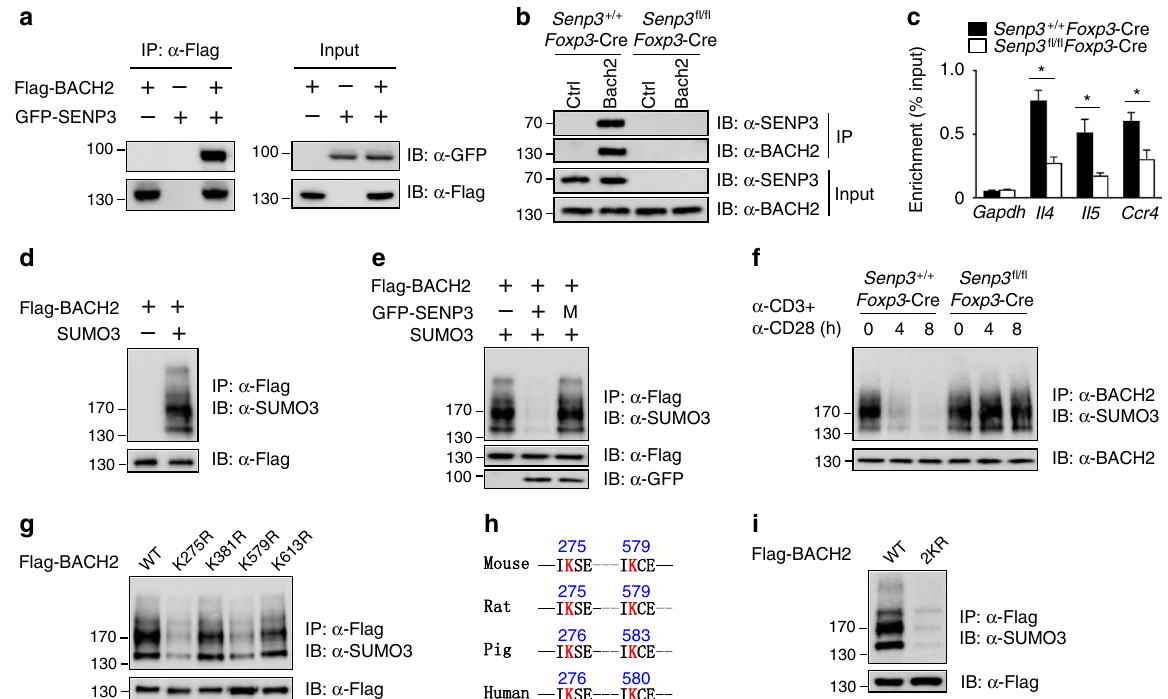
Fig. 5 SENP3 mediates BACH2 deSUMOylation in Treg cells. a SENP3-BACH2 co-immunoprecipitation (co-IP) assays using HEK293 cells transfected with the indicated expression vectors. b Lysates from Senp3 + / + Foxp3 -Cre and Senp3 fl / fl Foxp3 -Cre splenic Treg cells stimulated with anti-CD3 and anti-CD28 antibodies for 24 h were subjected to IP using anti-BACH2 antibody or control Ig (Ctrl); BACH2 and BACH2-associated SENP3 were detected by immunoblotting (IB). c ChIP assay to evaluate the binding of BACH2 to the regulatory regions of Il4 , Il5 , and Ccr4 loci in Senp3 fl / fl Foxp3 -Cre and Senp3 + / + Foxp3 -Cre splenic Treg cells stimulated with anti-CD3 and anti-CD28 antibodies for 24 h. d , e BACH2 SUMOylation assays using HEK293 cells transfected with the indicated expression vectors. f BACH2 SUMOylation assays using Senp3 + / + Foxp3 -Cre and Senp3 fl / fl Foxp3 -Cre Treg cells stimulated with anti-CD3 and anti-CD28 antibodies for 0, 4 or 8 h. g Flag-tagged mouse BACH2 or its mutant variants were individually transfected into HEK293T cells for BACH2 SUMOylation assays. h Sequence alignment of the K275 and K579 SUMOylation sites of BACH2 in different species and conserved residues (red) are shown. i Flag-tagged mouse BACH2 (WT) or K275R and K579R mutant BACH2 (2KR) were individually transfected into HEK293T cells for BACH2 SUMOylation assays. All data shown are representative of three independent experiments. Error bars are the mean ± SEM values ( c ). Two-tailed unpaired Student ’ s t tests were performed ( c ). * P <